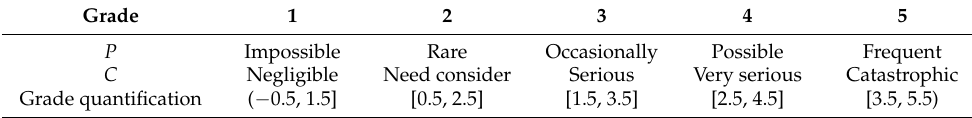
Table 5. Quantification unification of B * and the risk grade of the indices P and C .